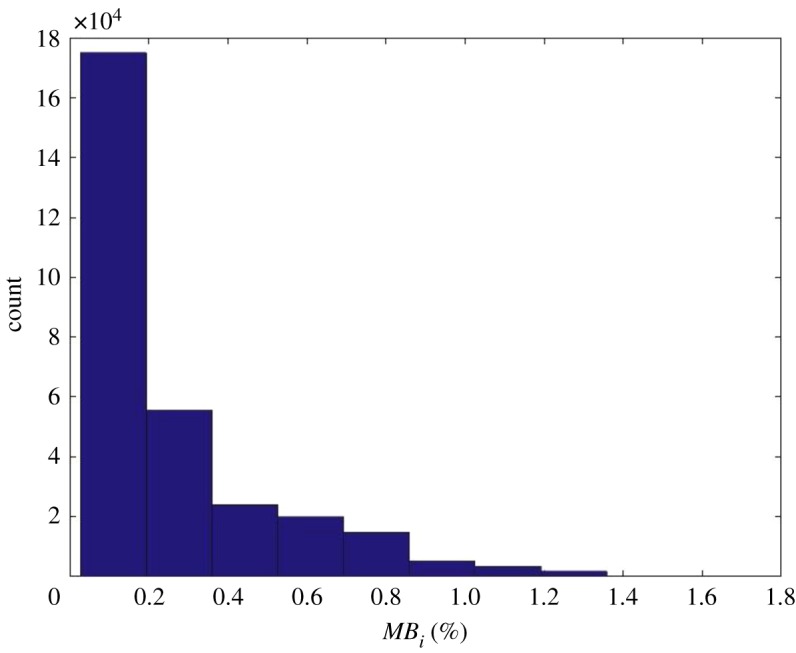
Histogram of the MBi values of all subdomains.